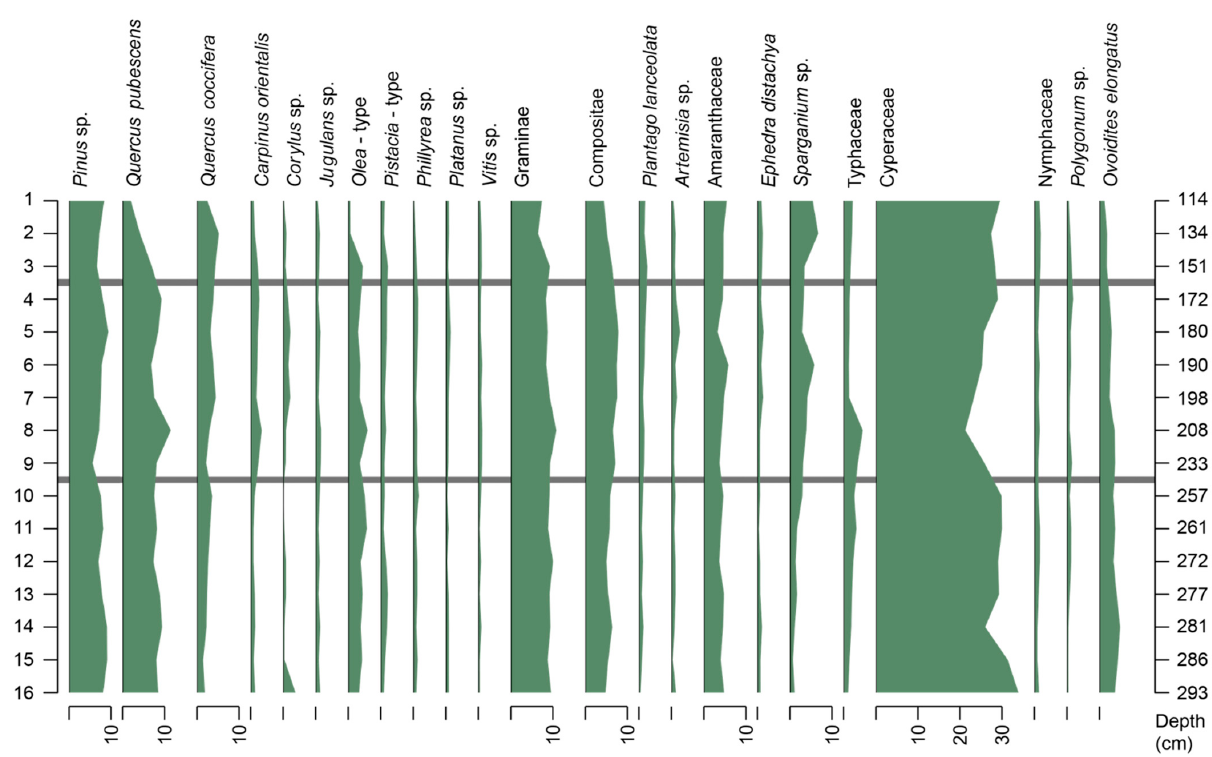
Figure 7. Stratigraphic plot for ALM3 pollen taxa (taxa with abundances higher than 10% are pre ‐ sent). The horizontal lines separate the three pollen